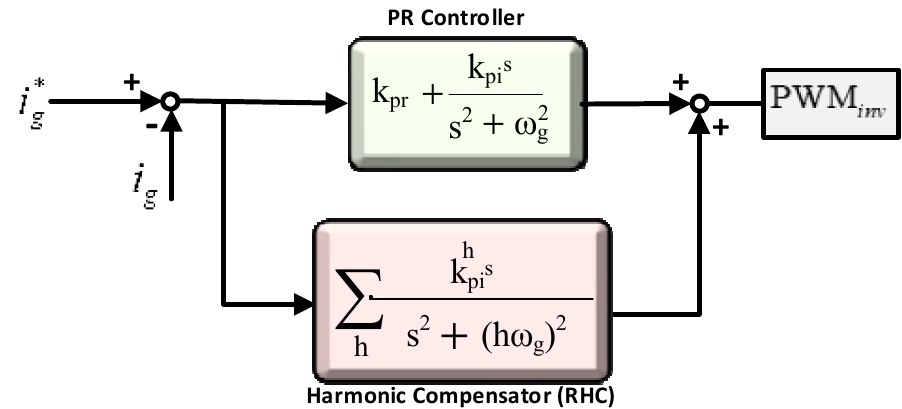
Figure 3. The proportional resonant controller with the resonant harmonic compensator.